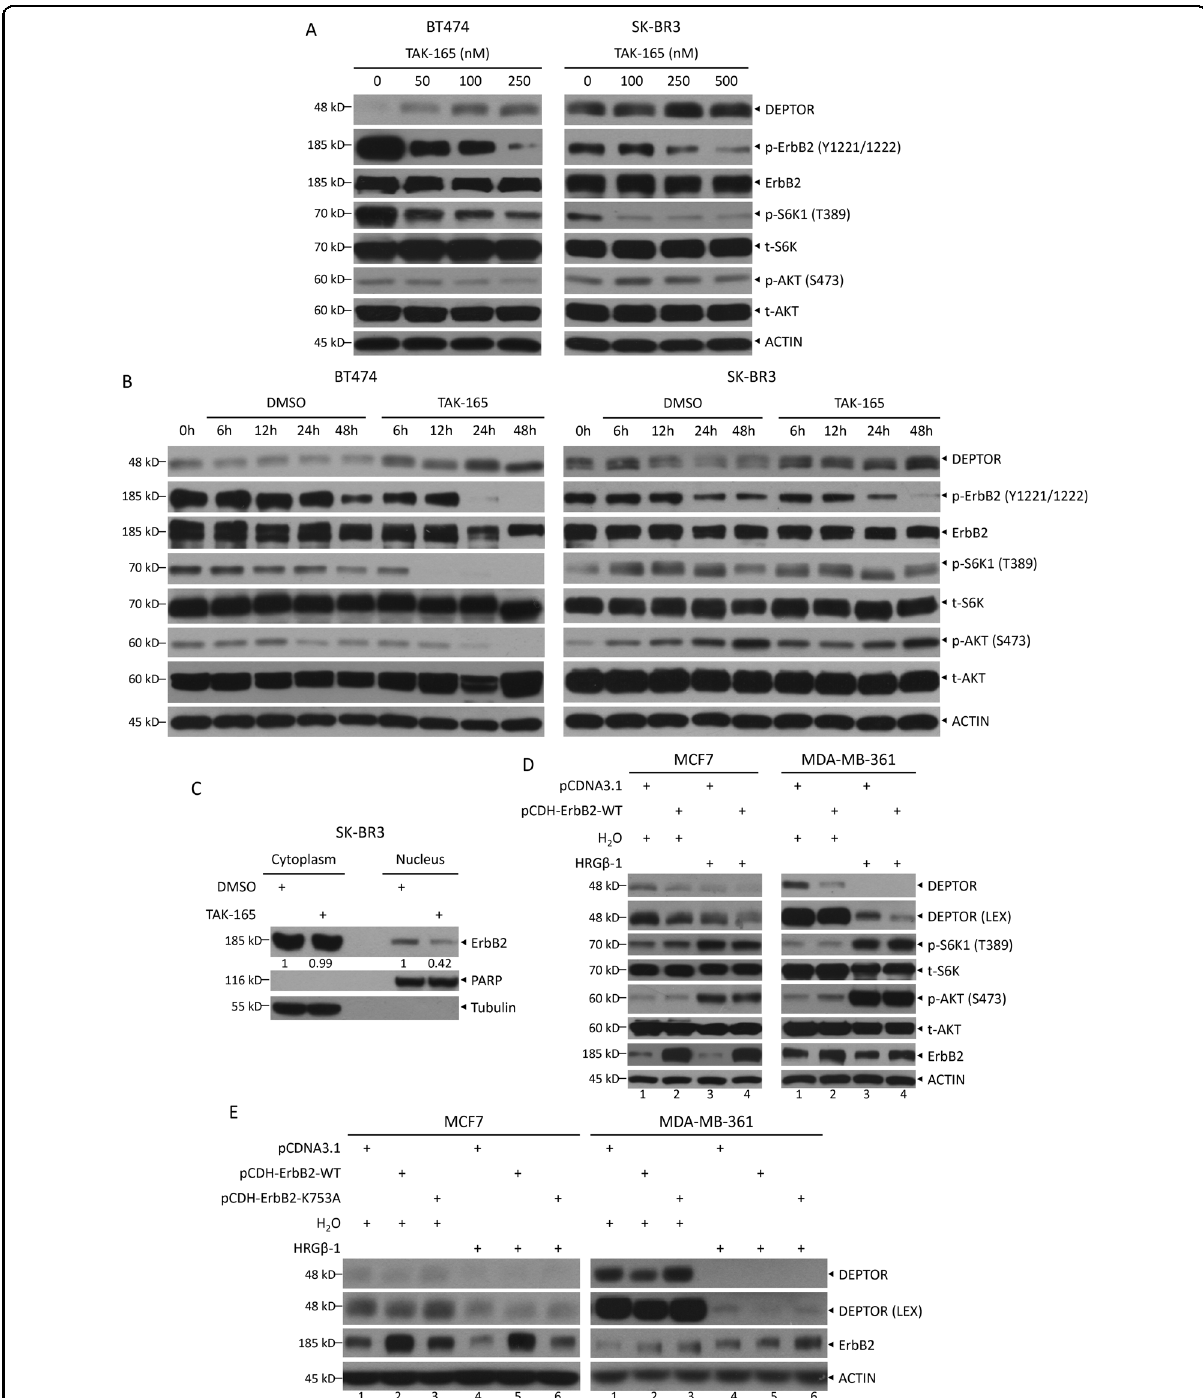
Fig. 3 The kinase activity of ErbB2 is required for ErbB2 nuclear translocation and transcriptional repression of DEPTOR. A Inhibition of ErbB2 by TAK-165 induces DEPTOR levels in a dose-dependent manner: BT474 and SK-BR3 cells were treated with various doses of the speci fi c ErbB2 kinase inhibitor TAK-165 for 24h, followed by western blotting with the indicated antibodies. B TAK-165 treatment induces DEPTOR levels in a time-dependent manner: BT474 and SK-BR3 cells were treated with 0.1 μ M or 0.25 μ M TAK-165 for various time periods, followed by western blotting with the indicated antibodies. C TAK-165 treatment reduces ErbB2 nuclear translocation: SK-BR3 cells were treated with TAK-165 for 48h and then subjected to nuclear fractionation, followed by western blotting with the indicated antibodies. The band density was quanti fi ed by ImageJ software and expressed as relative gray value, by setting the control value to 1. D , E . Wild-type, not kinase dead mutant, ErbB2 represses DEPTOR expression. Cells were transfected with indicated plasmids, and treated with or without 40ng/ml of HRG β -1 for 12h, and then, subjected to IB with indicated Abs. LEX longer